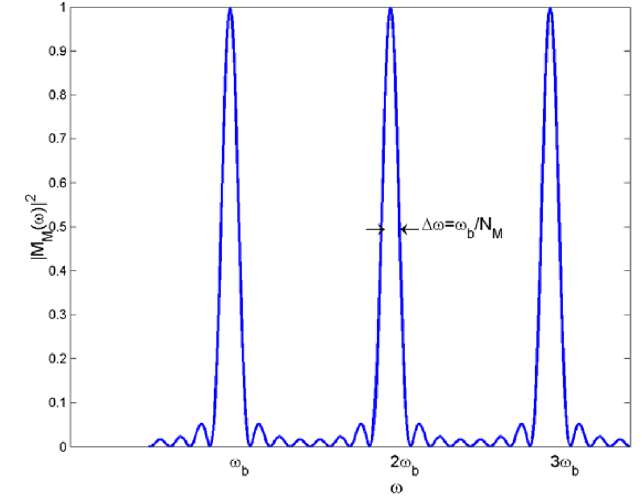
periodic train of N